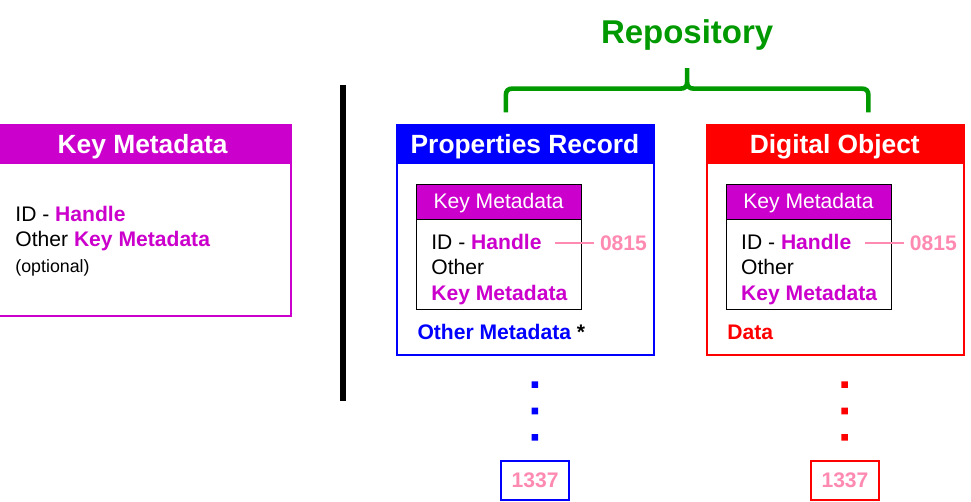
Figure 1. Properties of a Digital Object [* May Vary from Repository to